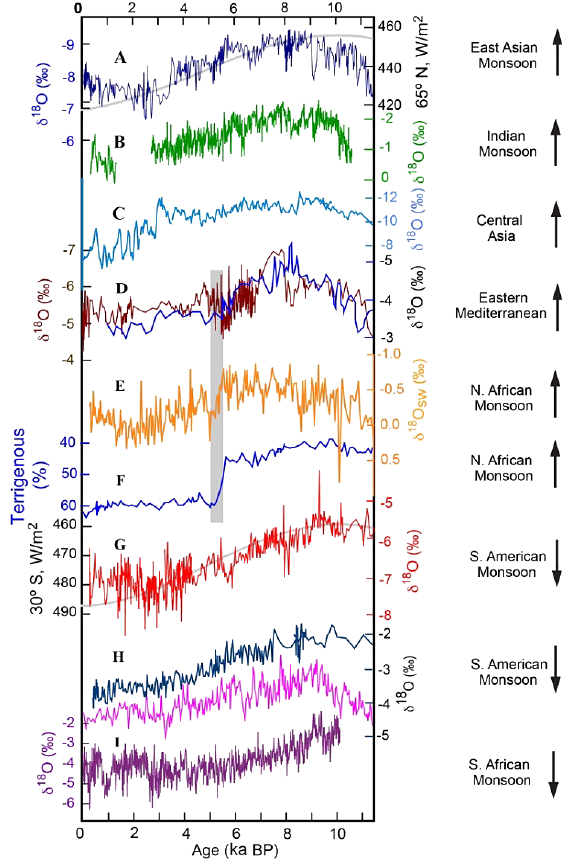
Figure 13. Holocene monsoon records from different monsoon regions. ( a ) The East Asian monsoon record from Dongge cave (Dykoski et al., 2005). ( b ) The Indian monsoon record from Qunf Cave (Fleitmann et al., 2003). ( c ) The Kesang record, east- ern–central Asia. Although it is outside of the modern Asian mon- soon domain, it may be influenced by the summer monsoon in- cursions during the mid-Holocene (Cheng et al., 2012b; Kutzbach et al., 2014). ( d ) Eastern Mediterranean records from Soreq Cave (brown, Bar-Matthews et al., 2003) and Jeita Cave, Lebanon (blue, Verheyden et al., 2008). ( e ) The seawater δ 18 O record from the ma- rine sediment core (MD03-270) (Weldeab et al., 2007). ( f ) The ter- rigenous concentration (%) record from the northwestern African margin sediment (ODP Site 658C, deMenocal et al., 2000). ( g ) The South American monsoon record from Cueva del Tigre Per- dido Cave, northern Peru (van Breukelen et al., 2008). ( h ) South American monsoon records from Botuverá Cave (pink, Cruz et al., 2005; blue, X. Wang et al., 2006). (i) The speleothem record from Cold Air Cave, Makapansgat Valley, South Africa (Holmgren et al., 2003). The records from Southern Hemisphere monsoon regions (g–i) are plotted inversely relative to their Northern Hemisphere counterparts (a–f) . Some of the locations of the above records are shown in Fig. 10. Summer insolation (gray curves) at 65 ◦ N (JJA, in a ) and 30 ◦ S (DJF, in (g) are also plotted inversely for comparison (Berger, 1978). It appears that the abrupt fall of the North African monsoon (the gray bar) correlates with low δ 18 O values in east- ern Mediterranean records (d) , and the latter is causally linked to a weakening of the North African